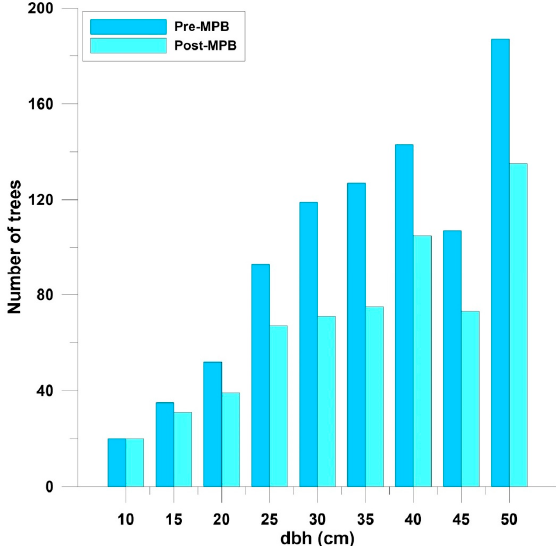
Figure 4. Number of live ponderosa pine trees pre- and post- a MPB event across dbh classes. The distributions were not different; Chi-square = 12.8, df = 10, p = 0.24. Arapaho-Roosevelt National Forest, Colorado, USA.